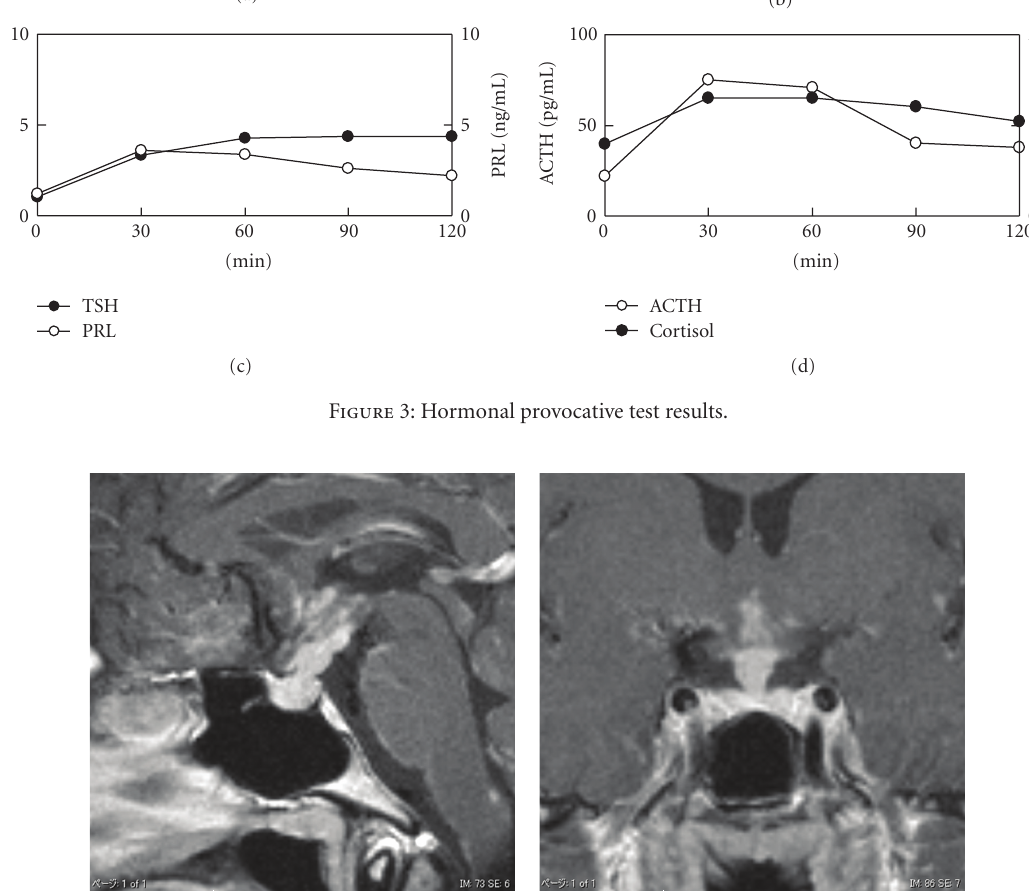
Figure 4: T1-weighted MRI of the sella turnica after administration of gadolinium revealed enhancing lesion centrally in the pituitary stalk, which spread continuously to the bottom of the third ventricle, and high intensity of posterior lobe was